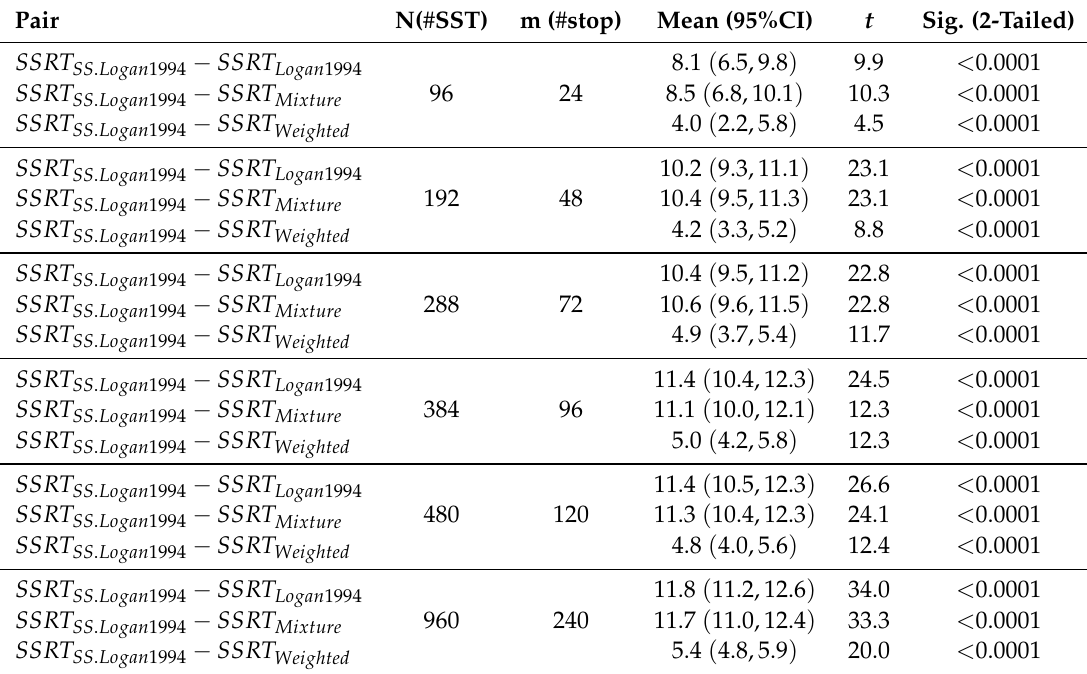
Figure 5. Regular and time series-based State-Space estimations of SSRT. Table 5. Paired t -test results of comparison between simulated time series-based state-space SSRT index and non time series-based counterparts by m (n =